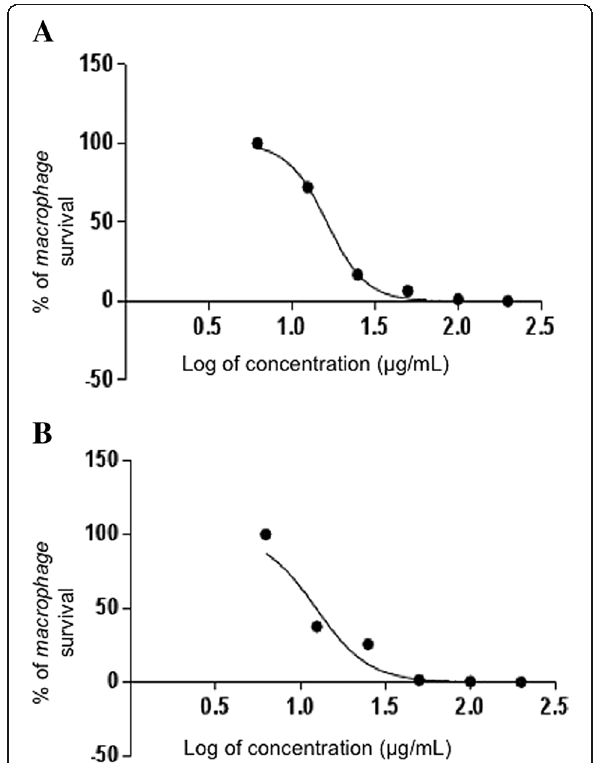
Fig. 4 a Dose-response curve of MTT assay for cytotoxicity in murine macrophages of PLA 2 and of ( b ) peptide fraction from Crotalus durissus terrificus